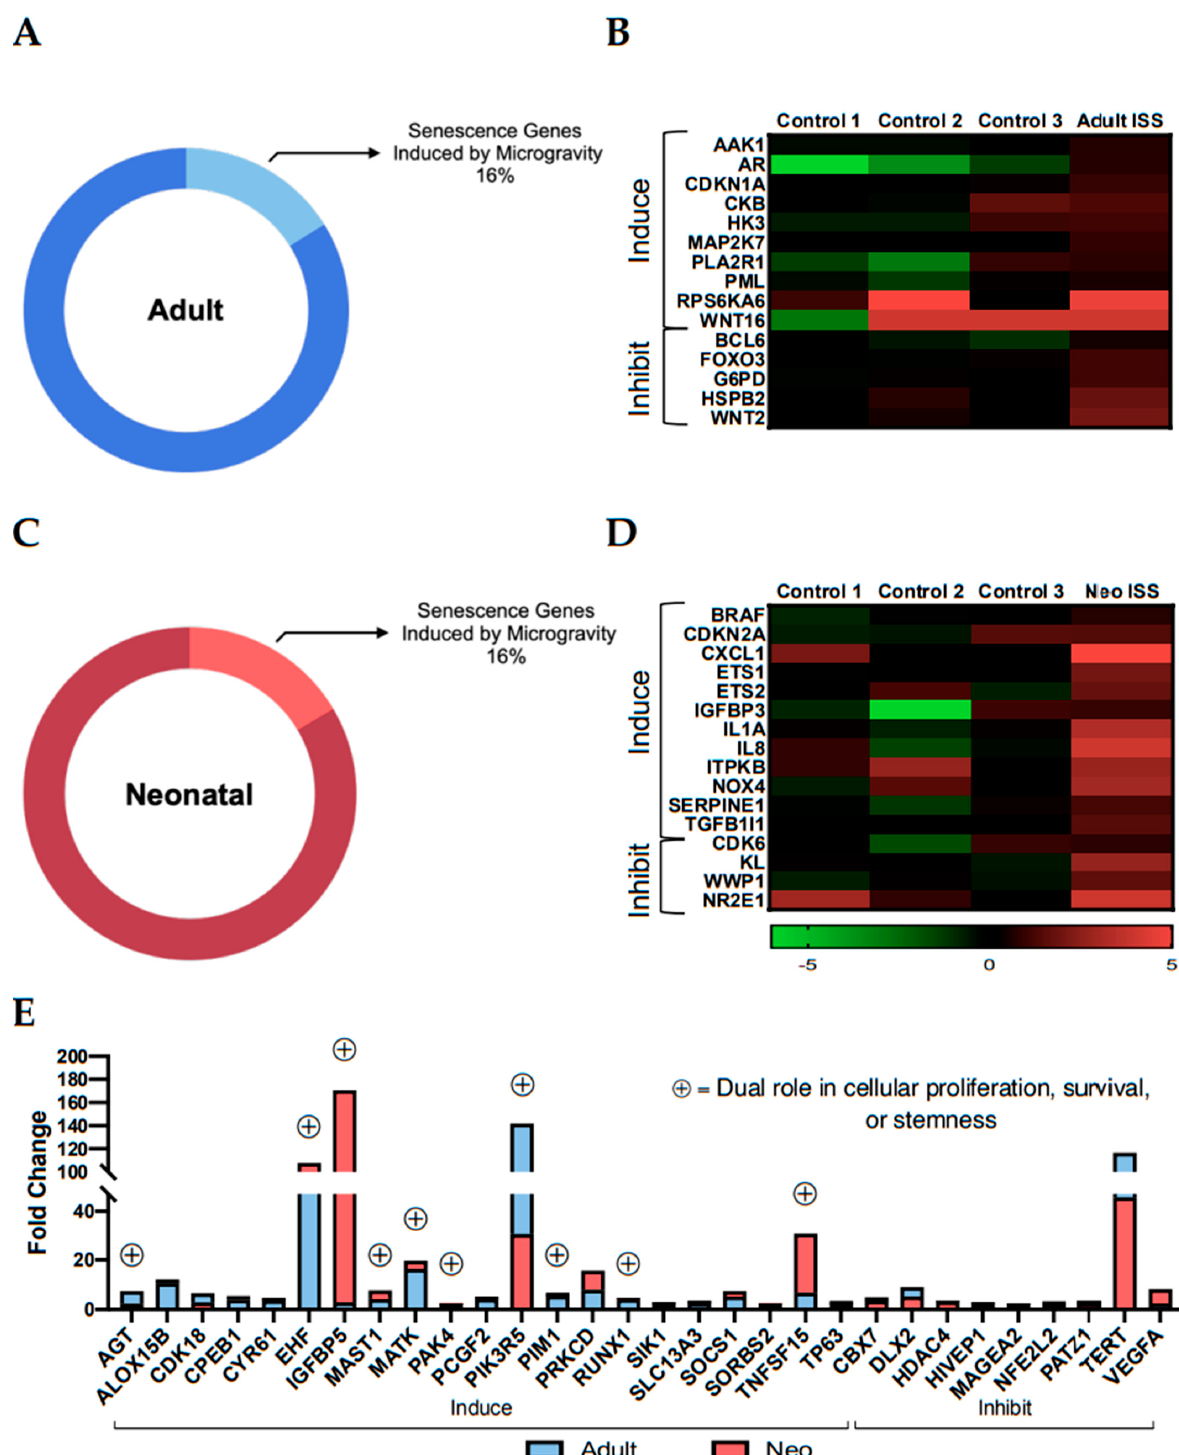
Figure 3. Spaceflight induced senescence genes that also play a role in stemness. ( A ) Adult CPCs induced 16% of senescence genes found in the CellAge database. ( B ) Ten senescence-inducing genes and five inhibiting genes were unique to the adult CPCs. ( C ) Neonatal CPCs induced 16% of CellAge senescence genes. ( D ) Sixteen genes were unique to neonatal CPCs: 12 inducing, 4 inhibiting. ( E ) Senescence-inducing genes that were shared between both age groups have dual roles in cell survival and proliferation.